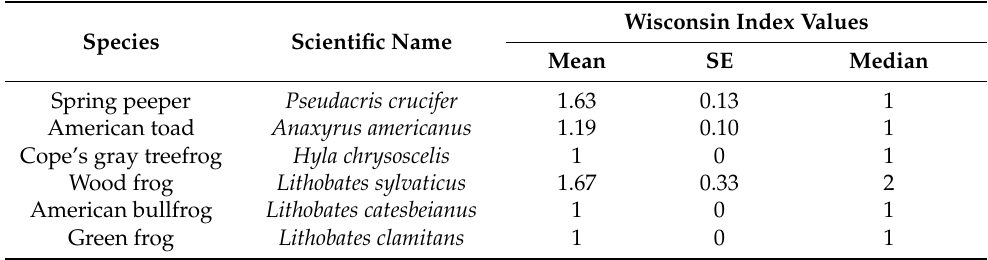
Figure 6. Variation of small mammal catch-per-unit-effort (CPUE; calculated as the number of captures per 100 trap nights) among the 12 traplines surveyed along Ruby Run at the JW Ruby Research Farm, Reedsville, West Virginia, USA, across years (2017–2020). Six unique species were captured across the four years: white-footed mouse ( Peromyscus leucopus ), deer mouse ( Peromyscus maniculatus ), short-tailed shrew ( Blarina brevicauda ), eastern chipmunk ( Tamias striatus ), meadow vole ( Microtus pennsylvanicus ), and meadow jumping mouse ( Zapus hudsonius ). Table 4. Anuran assemblage from nocturnal call surveys conducted within the riparian zone of Ruby Run at JW Ruby Research Farm in Preston County, West Virginia, USA, from 2017 to 2020. Average individuals per year is an estimate according to Wisconsin Index values given to each detection (1 = non-overlapping calls and an exact count of individuals could be made; 2 = overlapping calls with estimates of individuals made; 3 = calling in full chorus and assumed 50 individuals [17]).